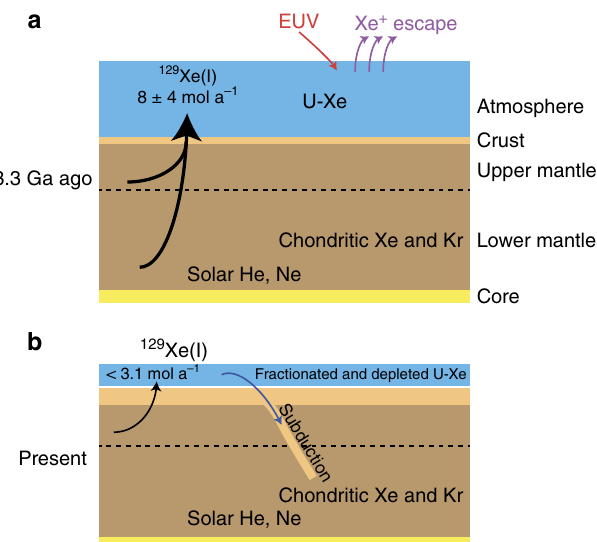
Figure 10 | Schematic view of the history of terrestrial Xe. Solar He and Ne (refs 6,57) and Chondritic Kr and Xe (refs 7,8) are present in the Earth’s mantle since the time of Earth’s accretion. The abundances and isotopic compositions of noble gases in the Earth’s core remain unknown. ( a ) 3.3Ga-ago, atmospheric Xe, derived from U-Xe, was still undergoing a progressive isotopic fractionation possibly from ionization by the EUV flux from the young sun (red arrow) and escape (purple arrows) processes 22,23 . Radiogenic 129 Xe, produced by the decay of now extinct 129 I ( T 1/2 ¼ 16Ma) was intensively ( 4 8mola (cid:2) 1 ) degassed (thick black arrow) from the whole mantle. Subduction of atmospheric Xe must have been non-existent or limited (see text and ref. 47). ( b ) Terrestrial Xe on the modern Earth. Isotopic fractionation of atmospheric stopped. The degassing of radiogenic 129 Xe is mainly via Mid-Ocean Ridge magmatism (thin black arrow) and atmospheric Xe is subducted back to the Earth’s mantle. Subduction (deep blue arrow) probably reaches the lower mantle. Reservoirs are not to interactions between the different reservoirs on Earth. A precise determination of the time-dependent evolution of the isotopic composition of atmospheric Xe could shed light on major events on Earth such as the timing of the onset of Xe subduction and the mechanisms and cessation of atmospheric escape. enables simultaneous analysis of K, Cl abundances and the isotopic composition of argon 48 . Before irradiation, each sample was wrapped in aluminum foil. Samples were placed in a quartz tube, evacuated and sealed to a maximum length of 6.5cm using a flame. Hb3gr hornblende samples, used as neutron flux monitors, were positioned at the bottom, and top of the quartz tube. Samples were irradiated (irradiation designated ‘MN2014b’) in the G-Ring In-Core Irradiation Tube facility of the TRIGA Reactor, Oregon State University. As the halogen-derived noble gas isotopes are produced by low energy thermal neutrons and epithermal neutrons, the irradiation cans were not Cd-shielded. Samples were irradiated for a few hour intervals each day over several weeks (22/4/14–1/7/14) to give a total irradiation time of 205h for MN2014b. The irradiation parameter J is determined from the measured 40 Ar/ 39 Ar ratio in the Hb3gr hornblende standards that were irradiated in the same tubes as the samples (equation 1): where t m is the age of Hb3gr of 1074.9 ± 3.5 Ma (ref. 49) and l is the total decay constant (5.531 (cid:3) 10 (cid:2) 10 a (cid:2) 1 , ref. 50). Values of J are 0.01789 ± 0.00008 and 0.01773 ± 0.00008 for Hb3gr monitors place at the top and bottom of the tube, respectively.